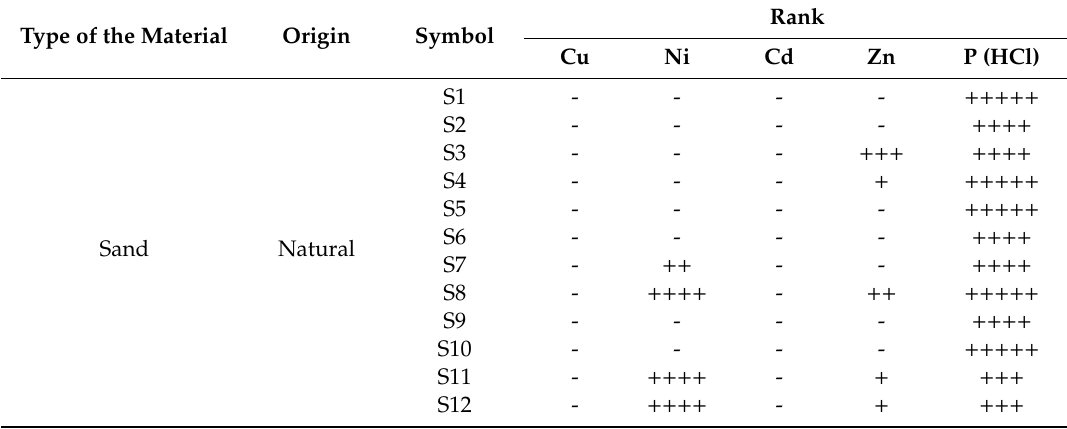
Table 3. The list of risky materials (green roof substrates components).